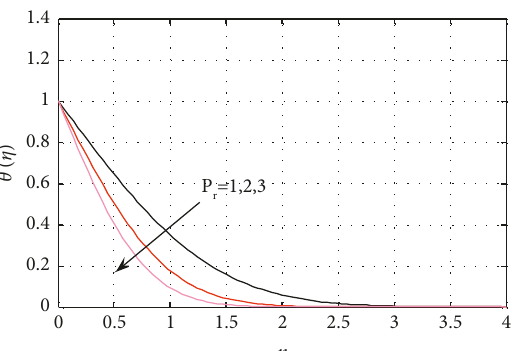
Figure 7: Impact of the Prandtl number on the temperature profile using A � 1 ,v Gr � 5 ,R � 0 . 1 ,S � 1 . 5 , c � 0 . m d c 1